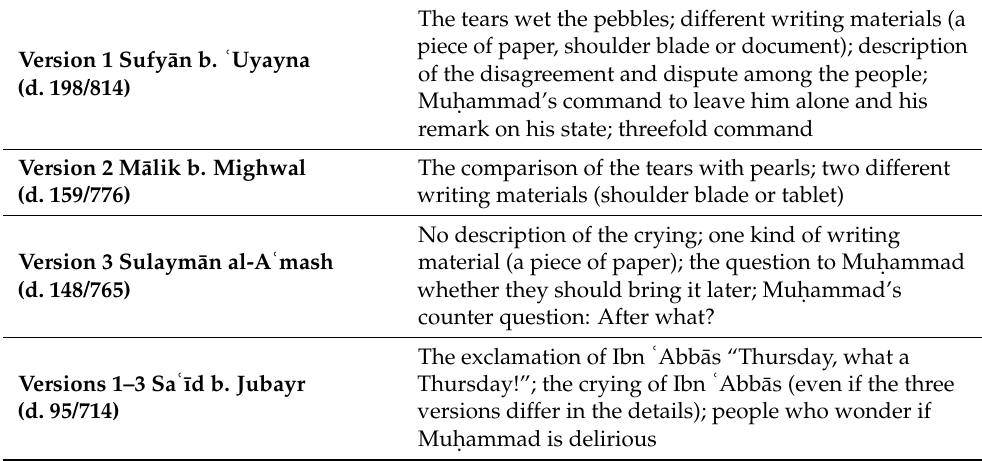
Table 2. The unique motifs of